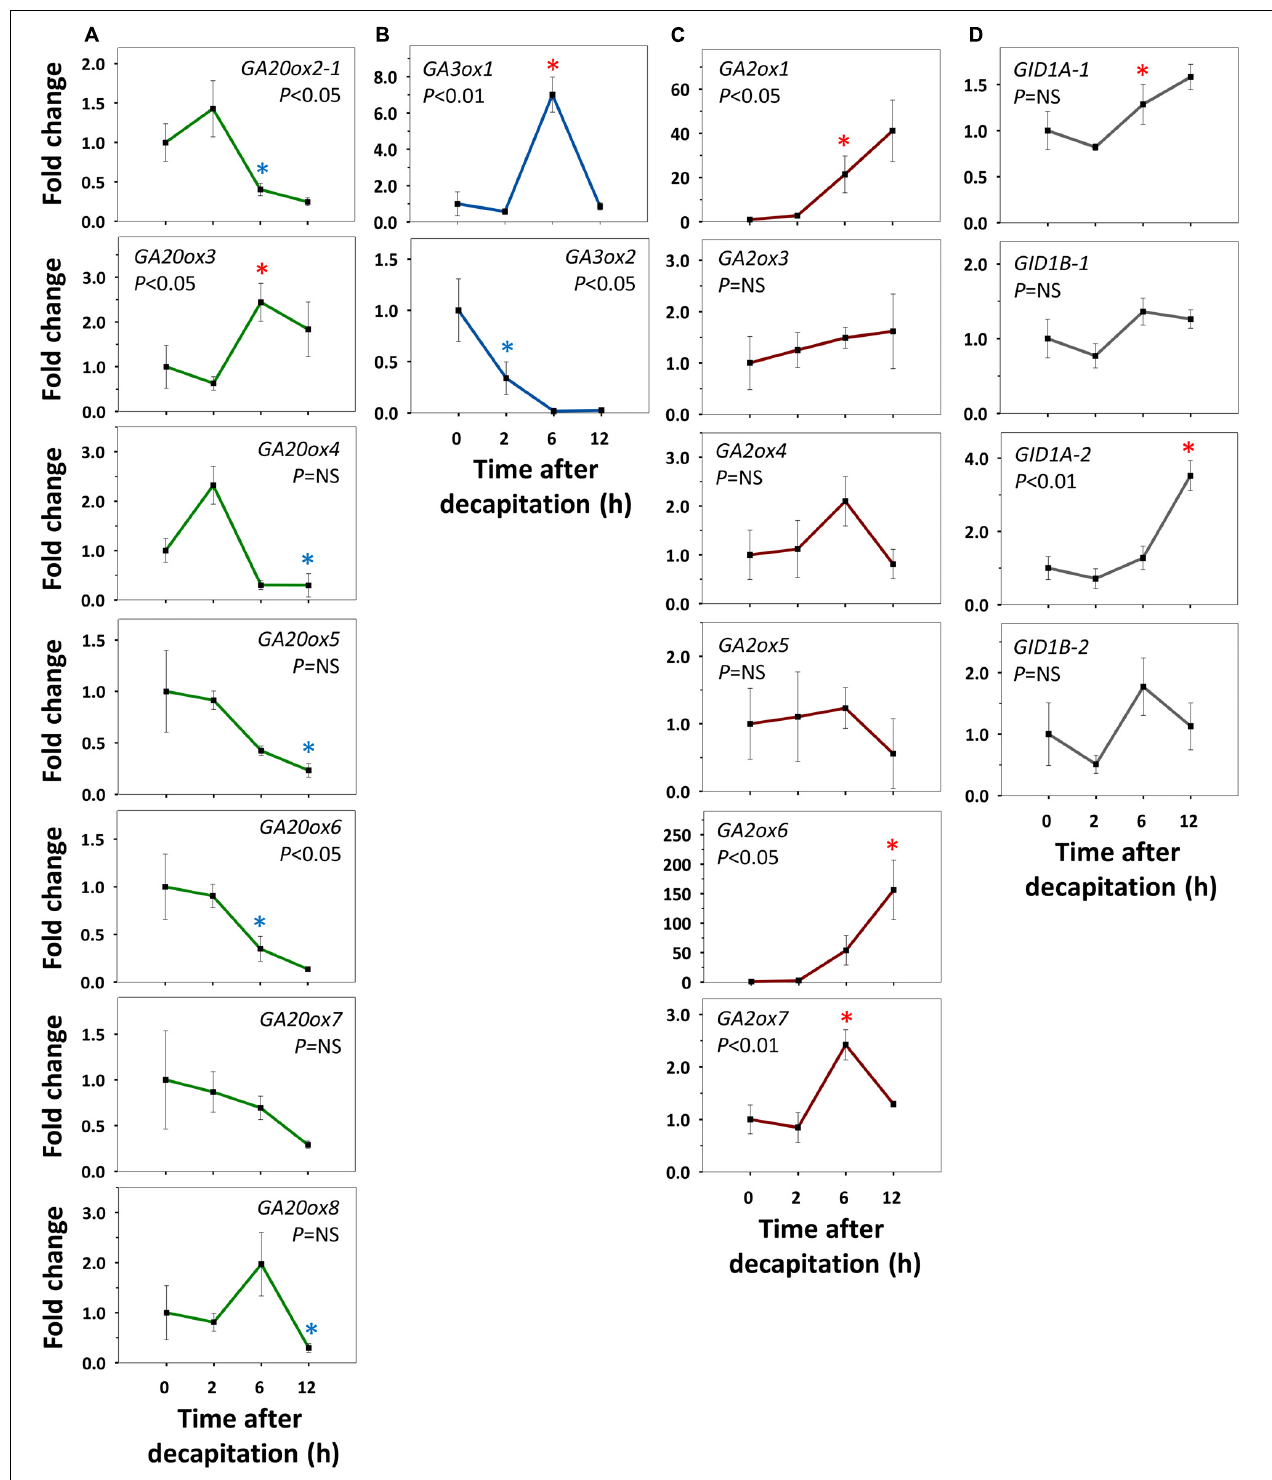
FIGURE 5 | Expression of gibberellin (GA) biosynthesis, deactivation and signaling genes in nodal bark after decapitation. (A) GA biosynthesis gene families encoding GA20-oxidases and (B) GA3-oxidases. (C) GA-deactivation gene family encoding GA2-oxidases. (D) GID1 -receptor genes. Relative expression (fold change) was analyzed at indicated times after decapitation in three successive nodes proximal to the decapitation point. Values represent the means of three biological replicates ± S.E. ( n = six plants). One-way ANOVA ( P -value; NS, not significant). Asterisk indicates the first significant decrease (blue) or increase (red), in gene expression in comparison to time 0 (Fischer’s LSD post hoc analysis, P -value at least < 0.05).